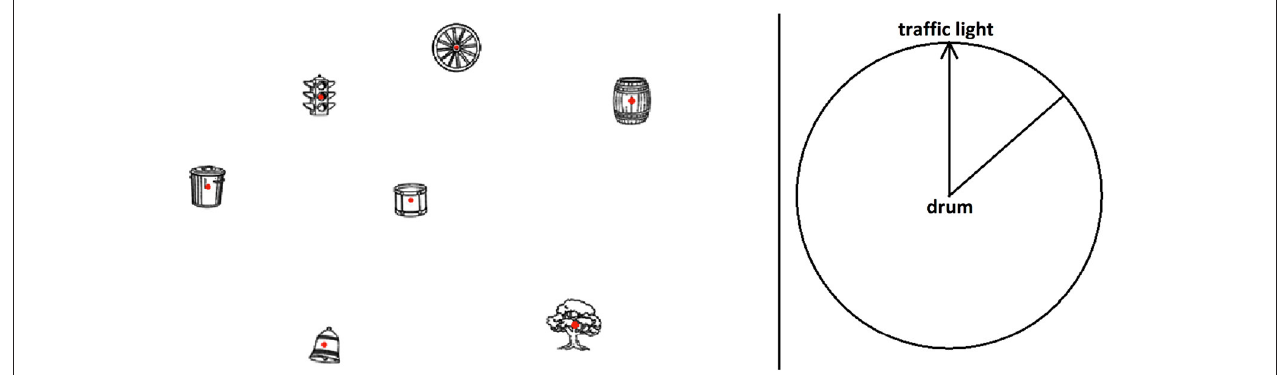
FIGURE 2 | Screenshot of a practice trial in Friedman et al.’s (2020) spatial orientation test (SOT). For clarity of presentation, each 2D object are shown in higher contrast, verbal instructions and object labels are also enlarged. The target direction in the upper right quadrant of the response circle (derived from the computer mouse actions of the lead author) shows the estimated position of the wheel relative to an initial heading that is to be imagined). Reproduced with permission under the Creative Common Attribution 4.0